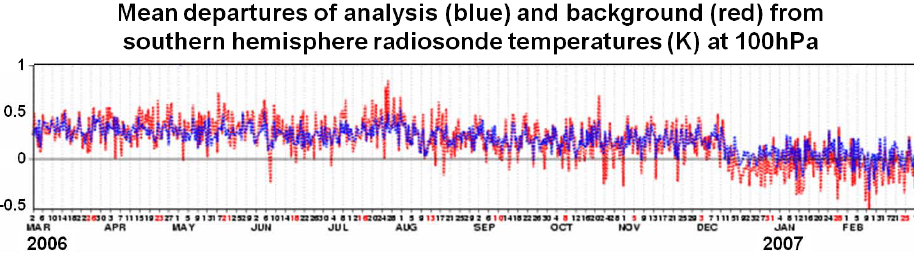
Fig. 27. Time series of the mean and standard deviations of the ECMWF background and analysis temperatures at 100hPa showing a reduction in the bias errors on 12 December 2006 when COSMIC data began to be assimilated (green arrow) (Luntama et al., 2008).